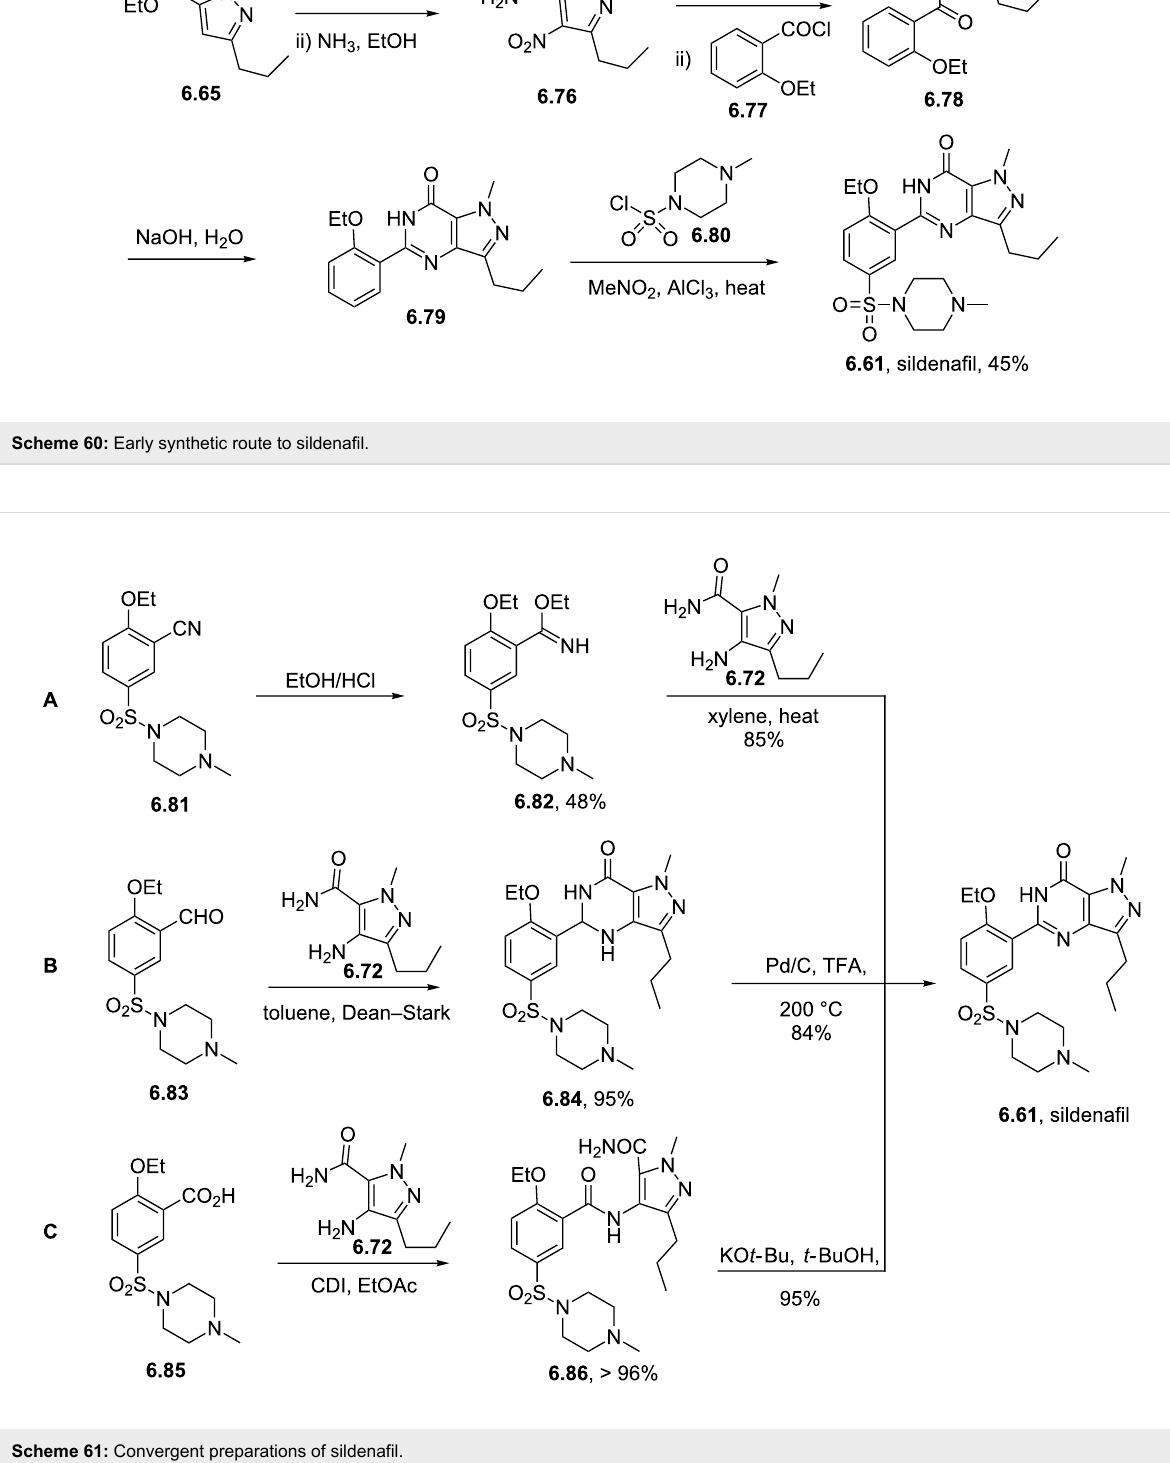
Scheme 61: Convergent preparations of